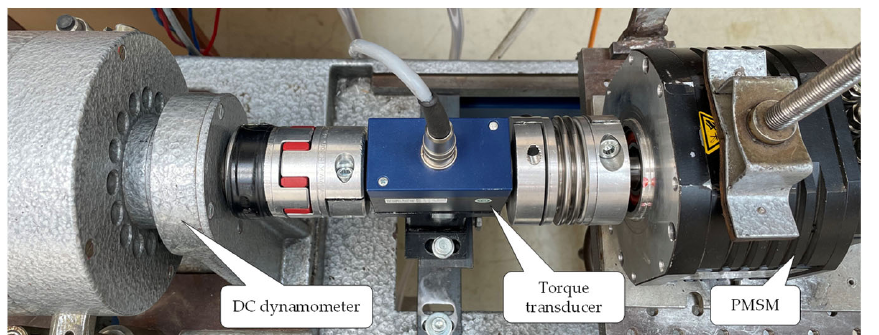
Figure 20. Experimental setup—enlarged view for PMSM, torque transducer, and DC dynamome ‐ ter.